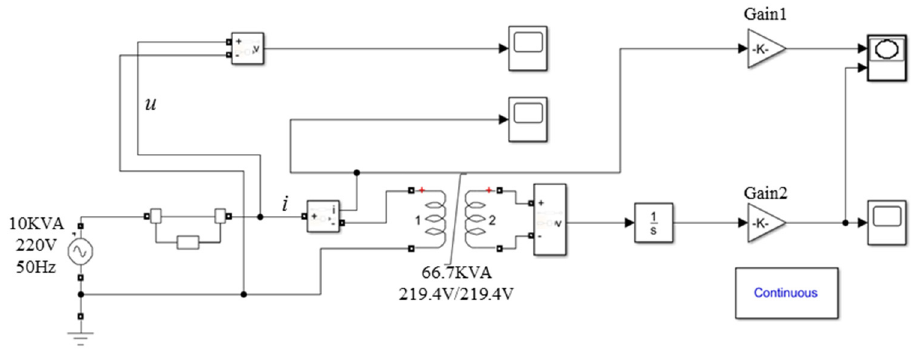
Table 1. Transformer test prototype main parameters.